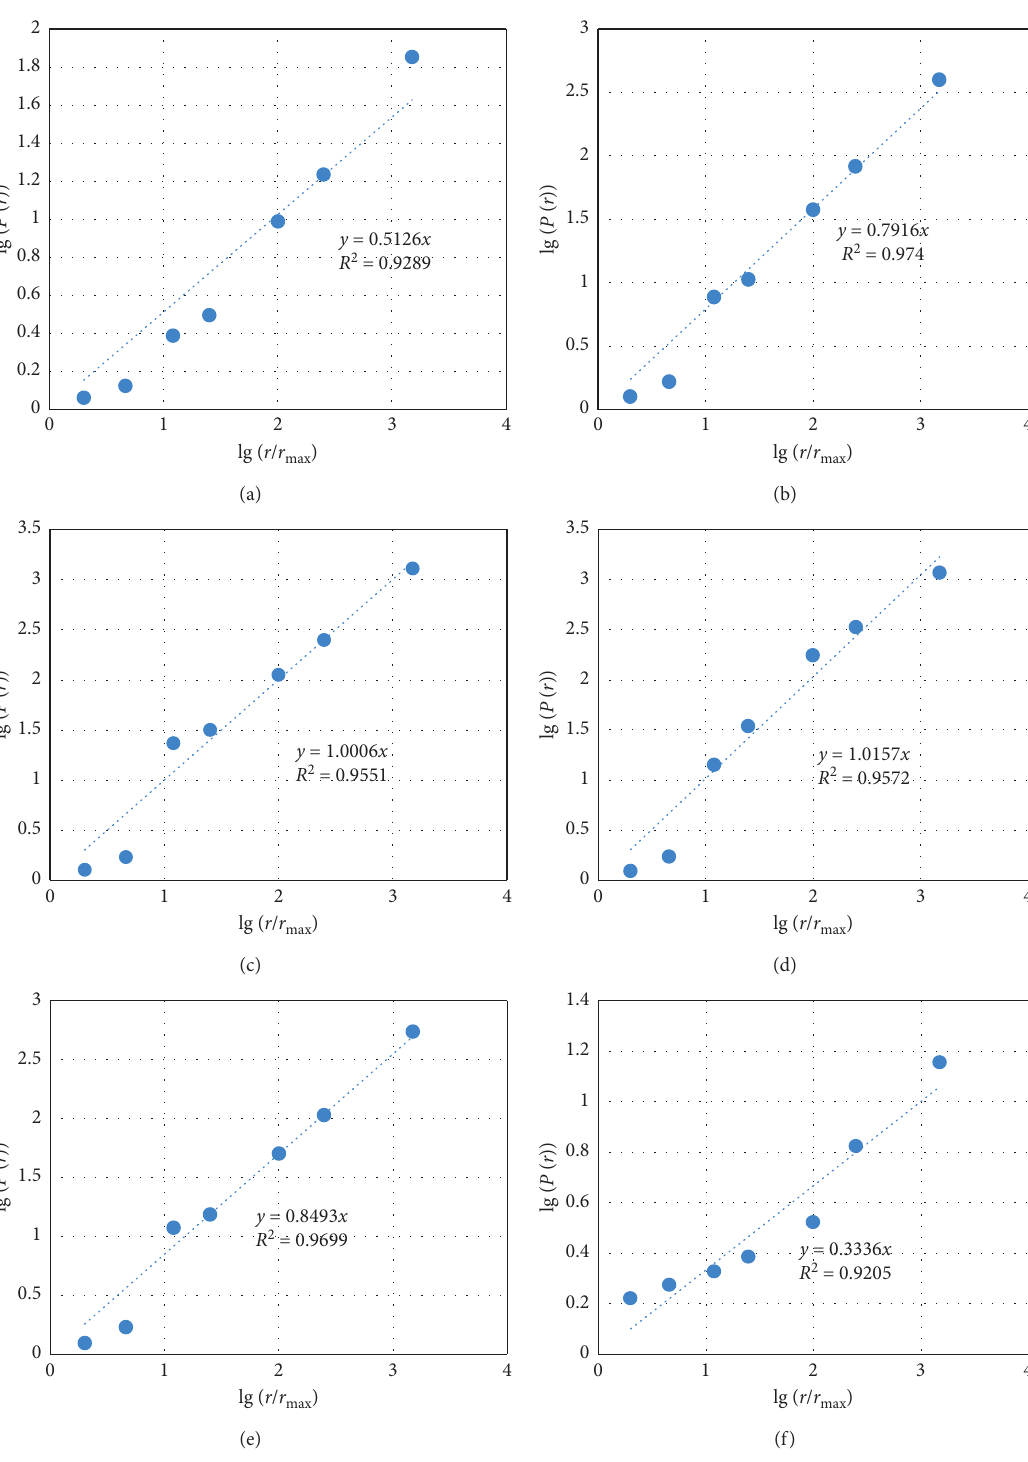
Figure 7: Fractal dimension scatterplots. (a) Jiuronggou. (b) Jianmugou. (c) Dadanongba. (d) Qiemunongba. (e) Qiuzhunongba. (f)